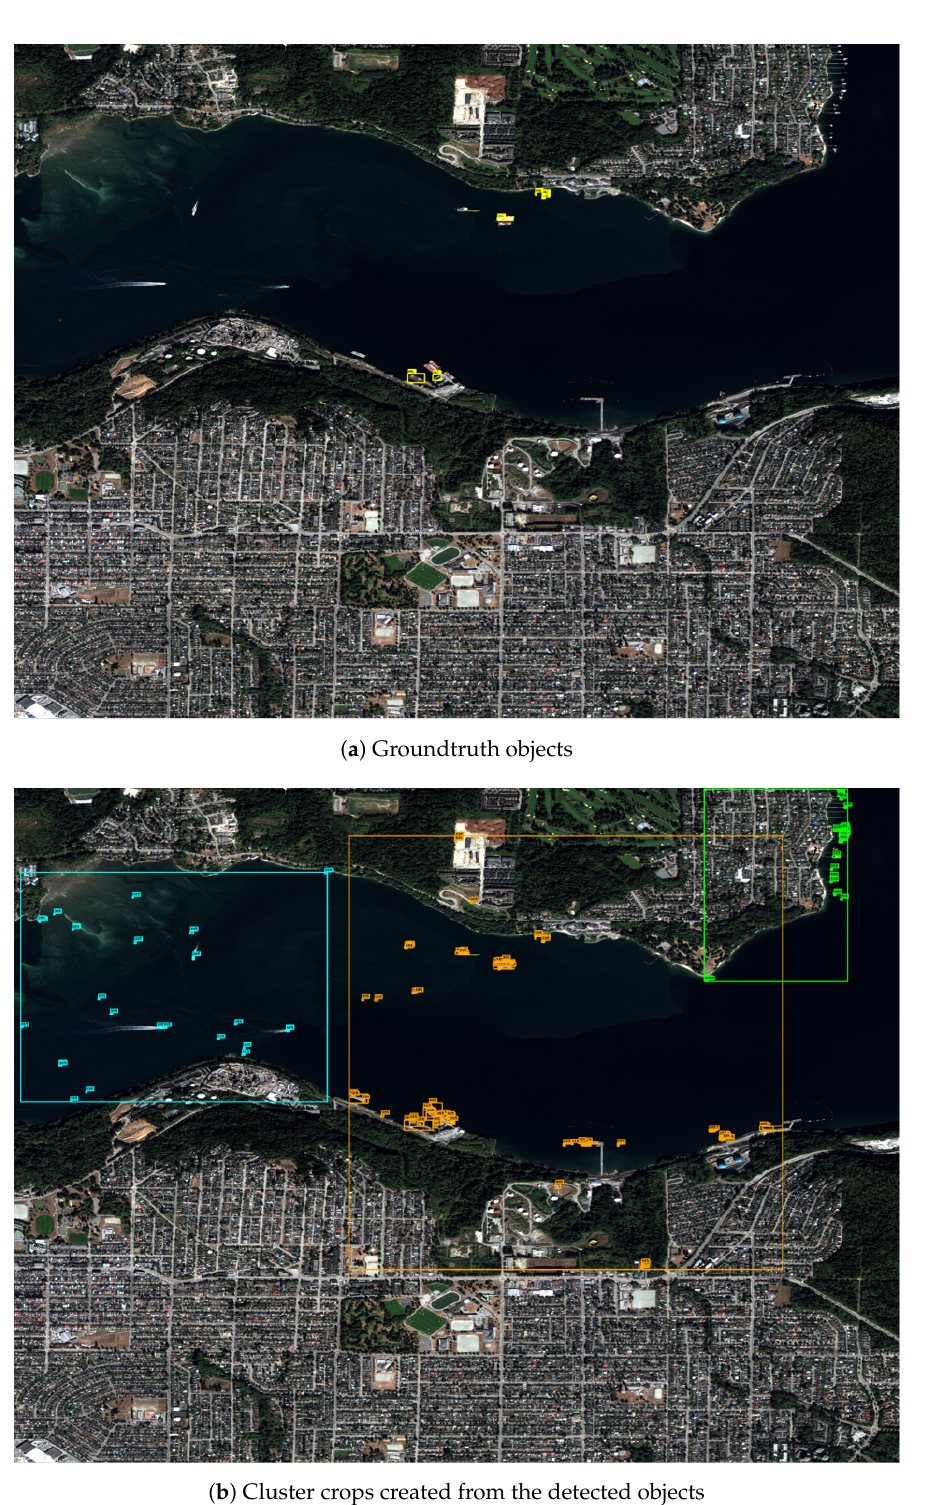
Figure 8. Example cluster crops on the satellite image taken from the harbor-peripheral areas. Each generated cluster crop and the associated object proposals are indicated by the same color. These WorldView-3 images are provided by DigitalGlobe